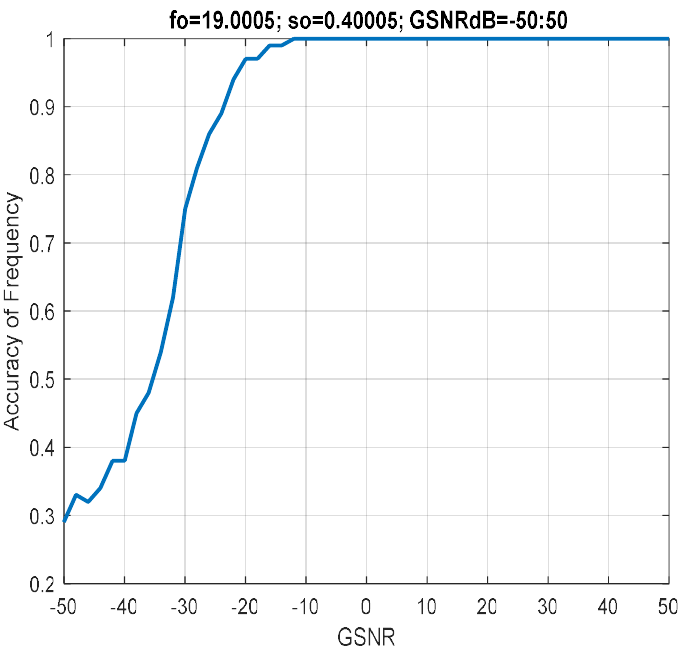
Figure 21. Accuracy of FE for noisy LFM by CNN, where f o = 19.0005.